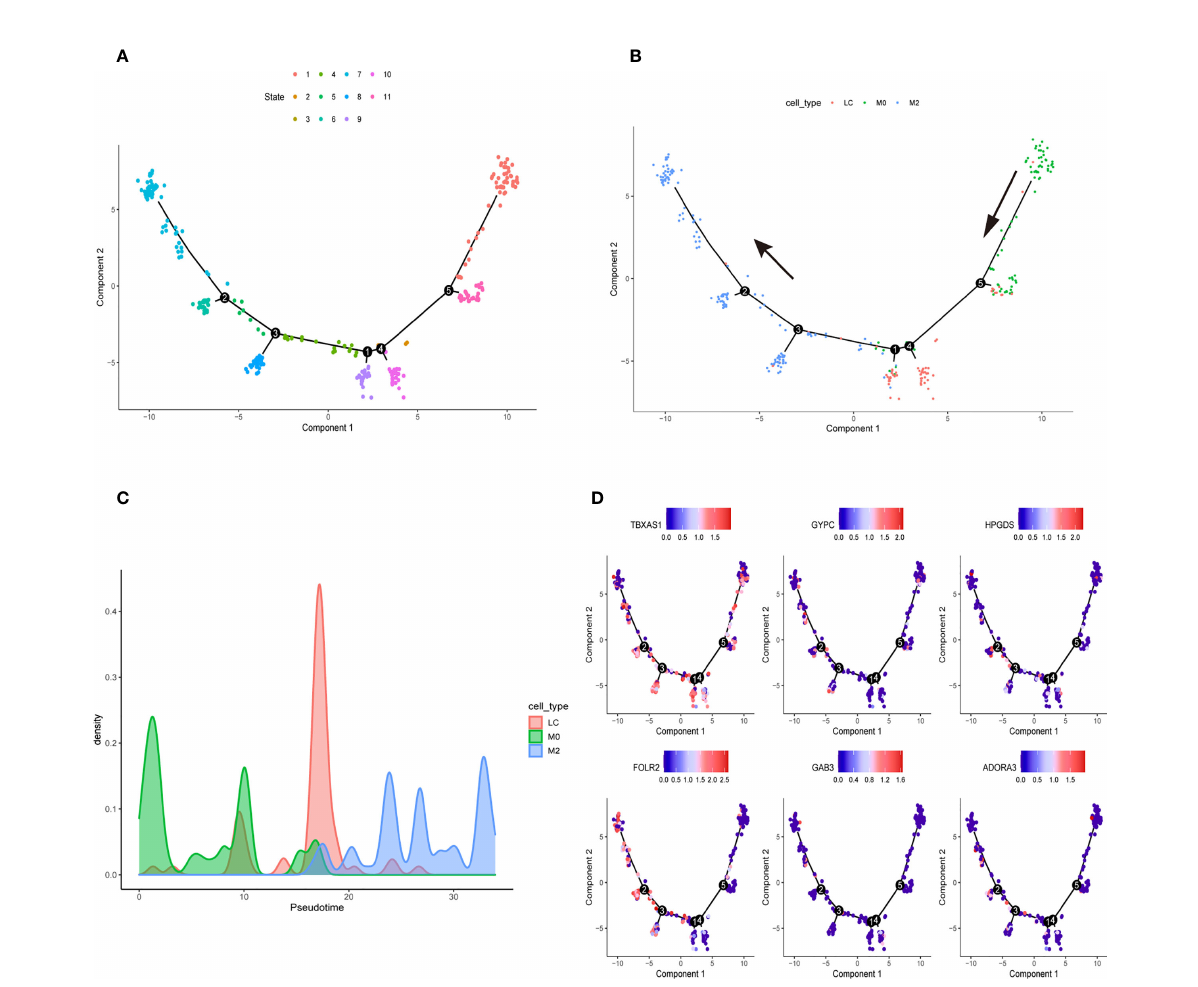
FIGURE 8 Cell Trajectory Reconstruction and Pseudo-temporal Analysis (A) Construction of cell trajectory by cell state (B) Construction of cell trajectory by cell type. (C) Cell density plots along the time axis. (D) The expression level of six genes in the macrophage trajectory